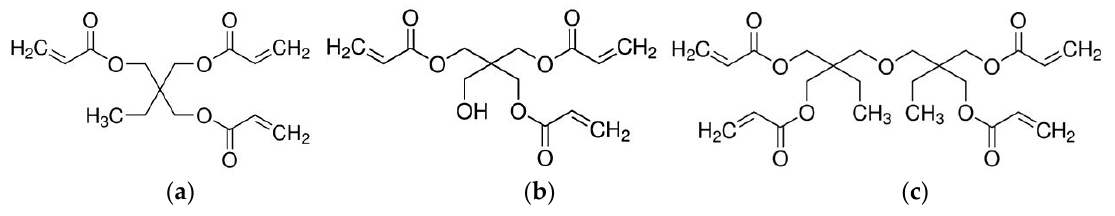
Figure 1. Used polyfunctional acrylate comonomers: ( a ) trimethylolpropantriacrylate (TMPTA); ( b ) pentaerythritol triacrylate (PETA); ( c ) di(trimethylolpropane) tetraacrylate (DTTA).